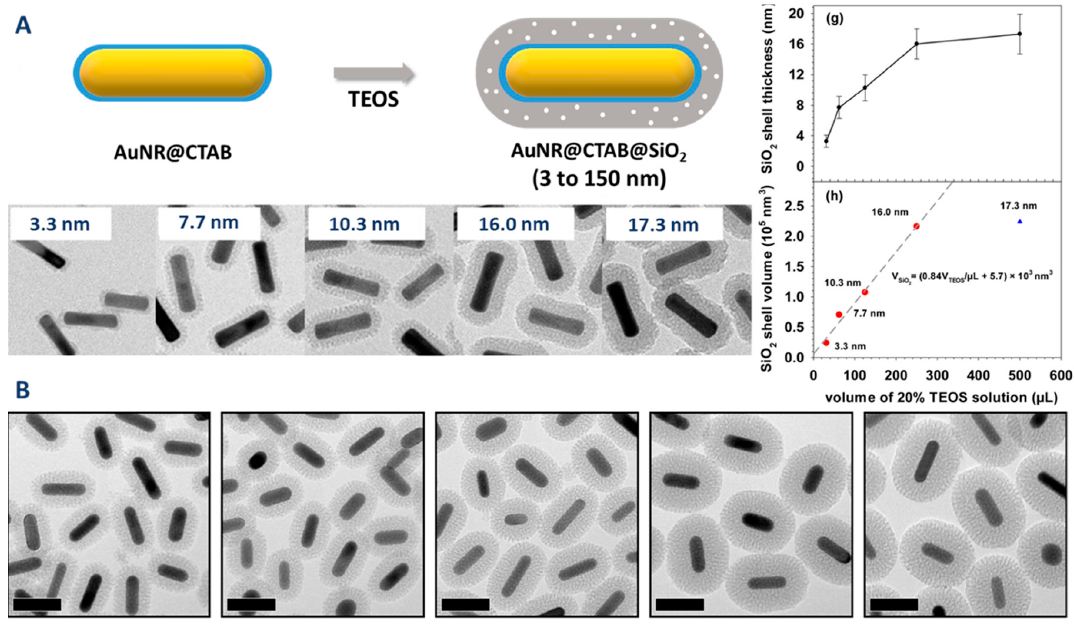
Figure 9. ( A ) Variation of silica coating thickness with amount of added TEOS: Left: TEM images (numerical values reported on each TEM are amount of TEOS and average coating thickness); right: Average thickness (top) and average volume (bottom) of silica coating vs. volume of added TEOS illustrating the complete conversion of TEOS to SiO 2 shell up to 250 μ L of 20% TEOS (red dots) and incomplete conversion above (blue triangle) (from [81]). ( B ) Variation of silica coating thickness with CTAB concentration: From left to right 1.2, 1.0, 0.9, 0.7, 0.4 (from [82]), the bar scale corresponds to 50 nm.